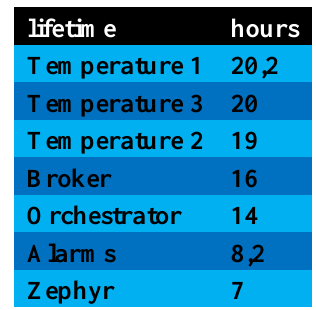
Table 2. Time for a node to deplete its